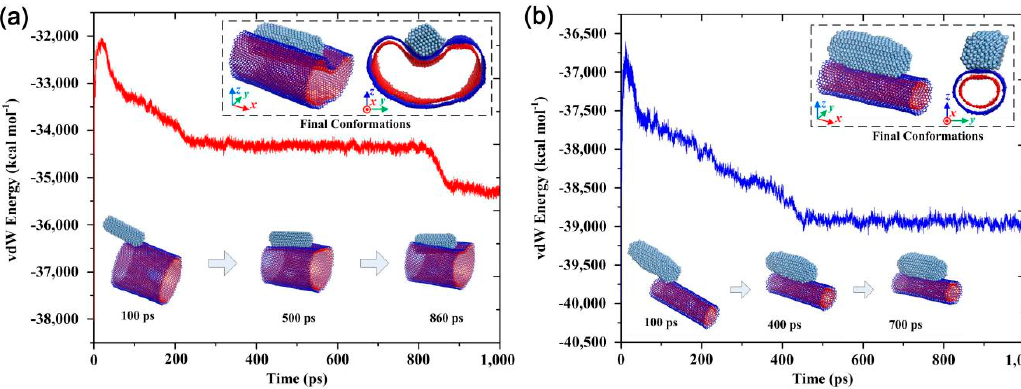
Figure 4. The relationship between vdW energy and simulation in ( a ) a large-diameter AgNW–DWNT (double-walled carbon nanotube) and ( b ) small-diameter AgNW–DWNT systems with illustrated atomic configurations in different times at 500 K.